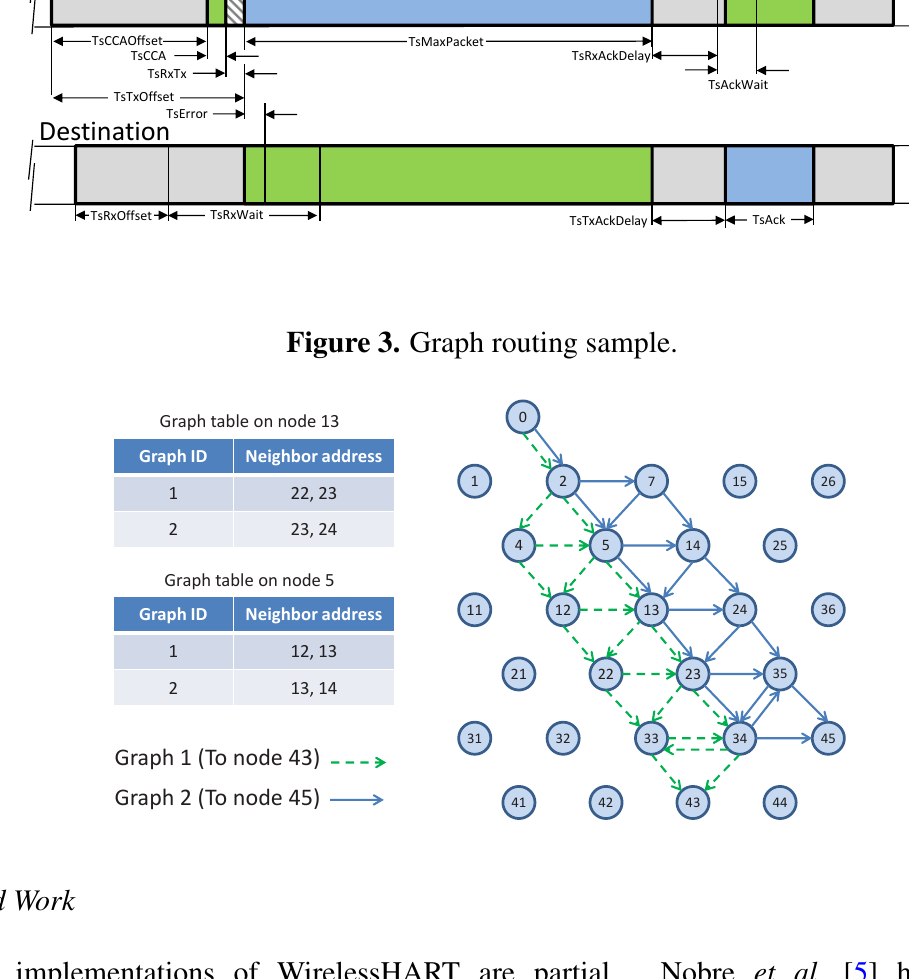
Figure 2. Timing of a dedicated TSCH timeslot.